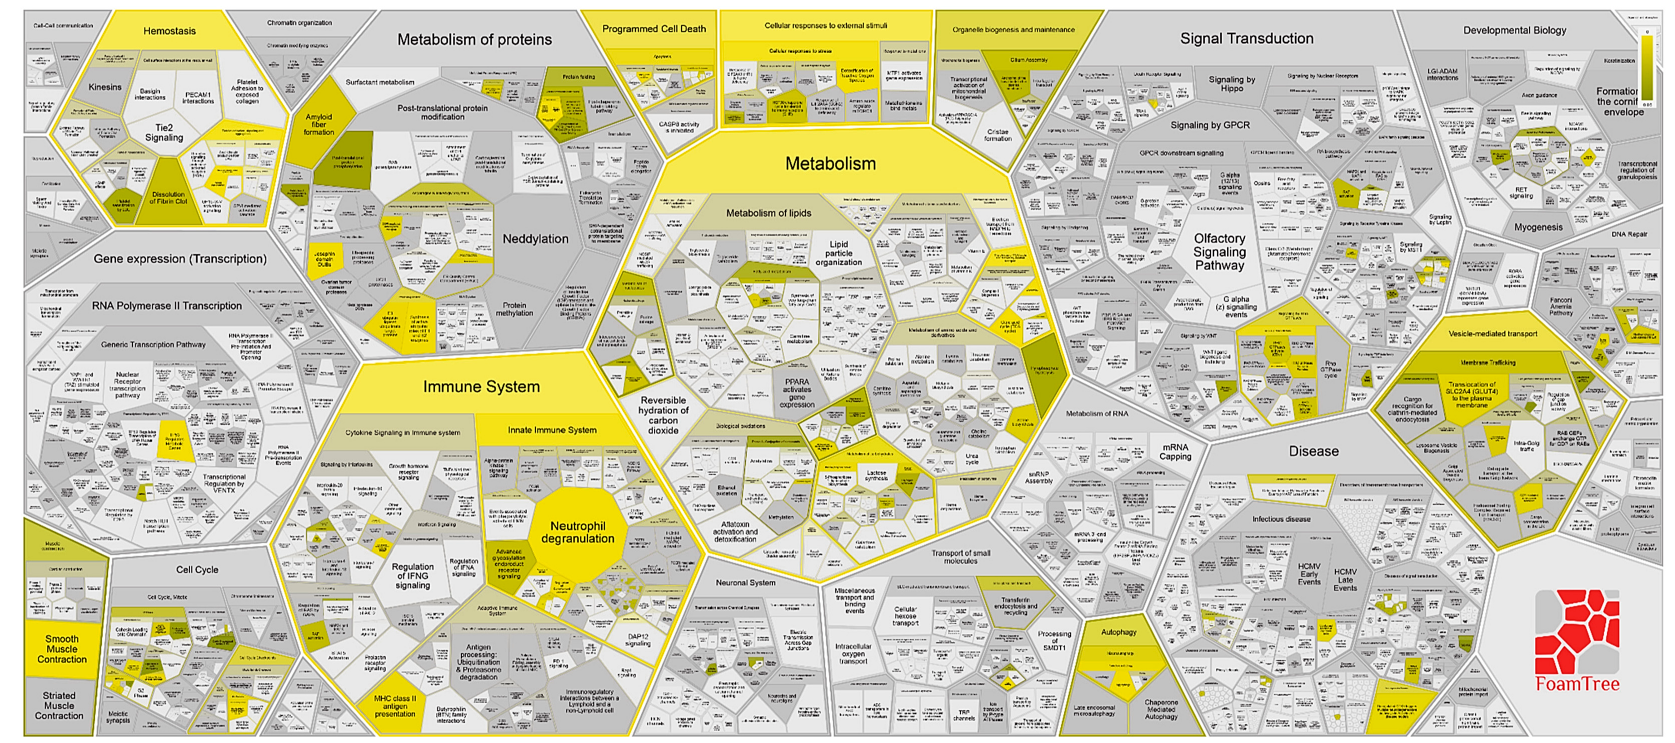
Figure 3. Voronoi diagram representation of the hierarchical pathways overrepresentation analysis by Reactome of the protein elements identified in ND GBM the tumor